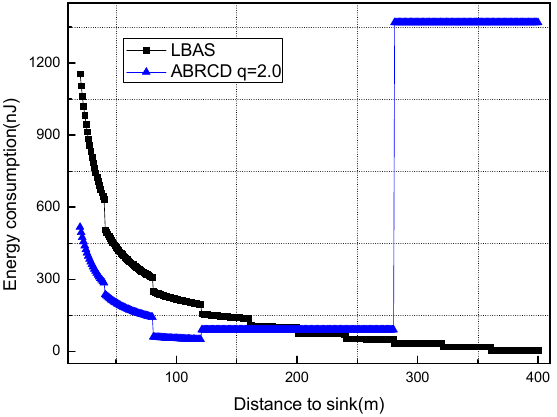
Figure 20. Energy consumption of nodes 20~400 m away from sink with q = 1.5.